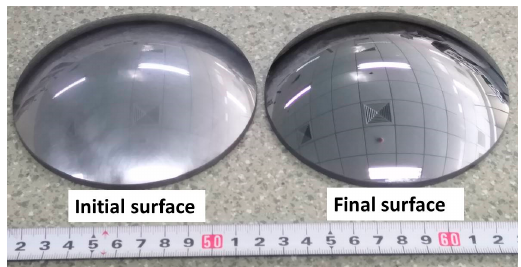
Figure 12. A picture of the initial surface ( left ) which is ground by diamond pellets and the final surface ( right ) in test B.